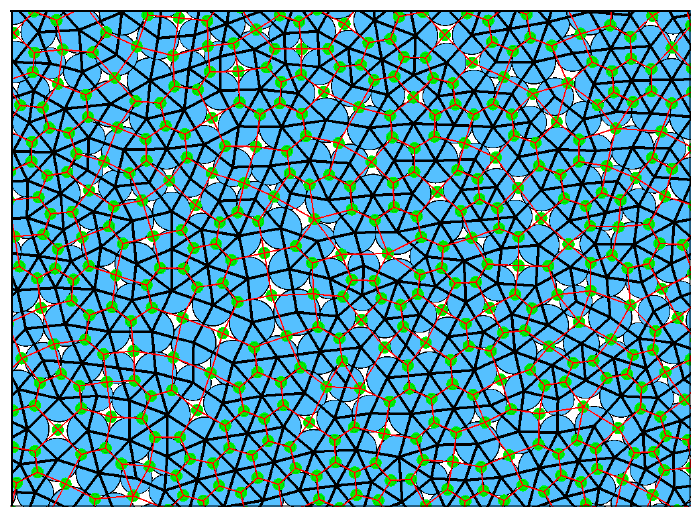
Figure 1. Model of pipes and domains.